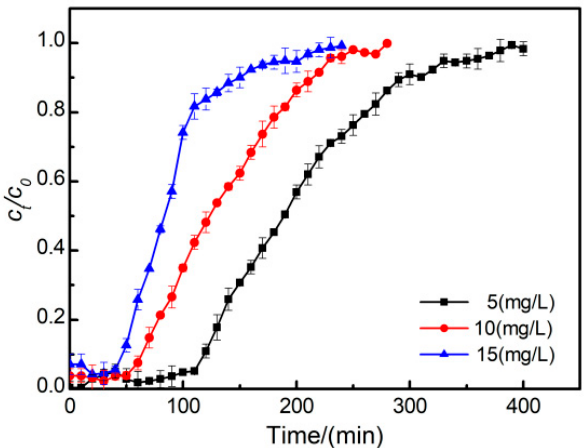
Figure 5. Effects of the initial Ph concentration on breakthrough curves.